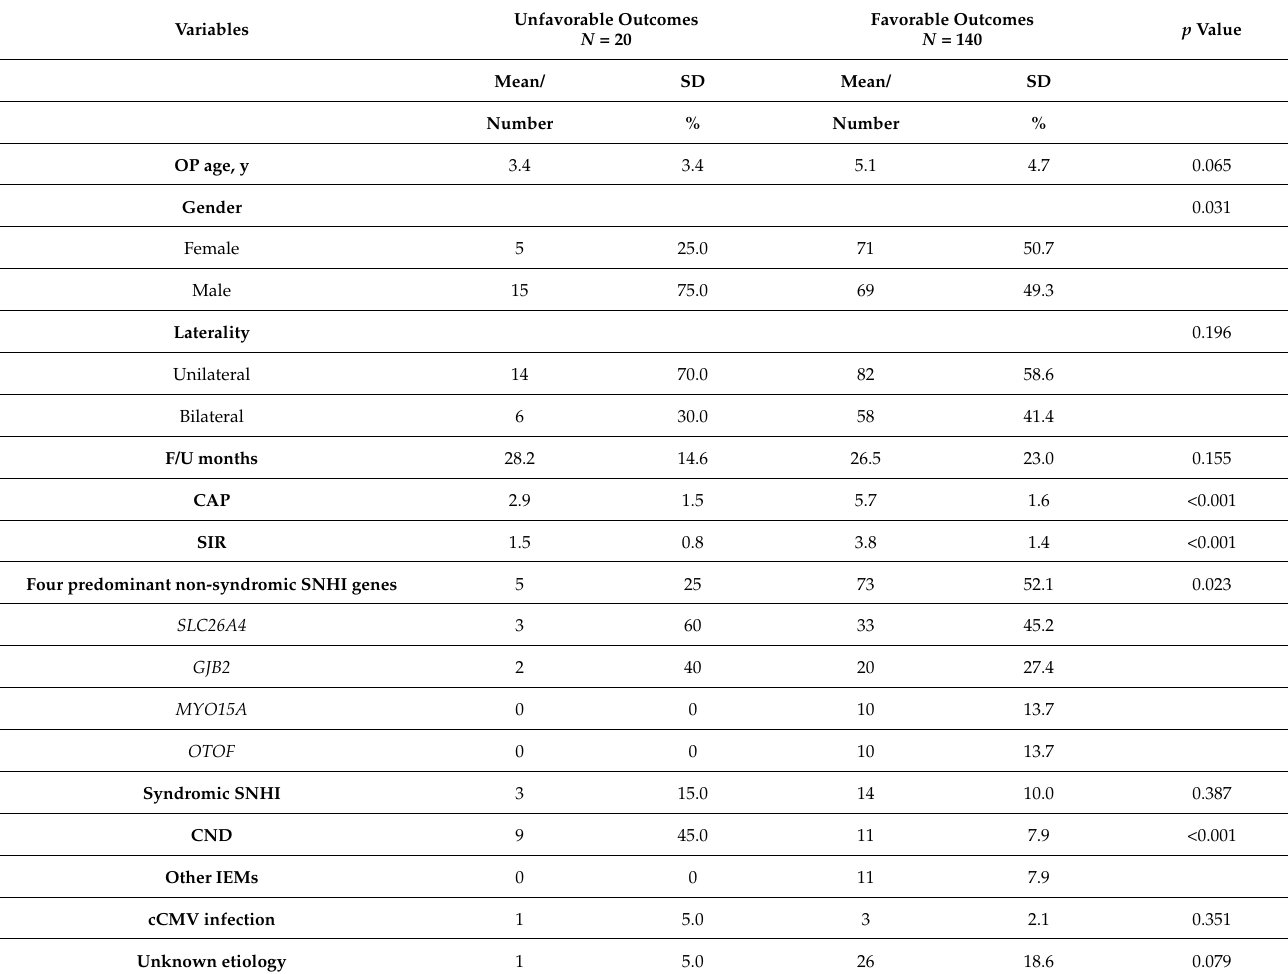
Table 4. Comparison of demographic features and etiologies between patients with favorable and unfavorable CI